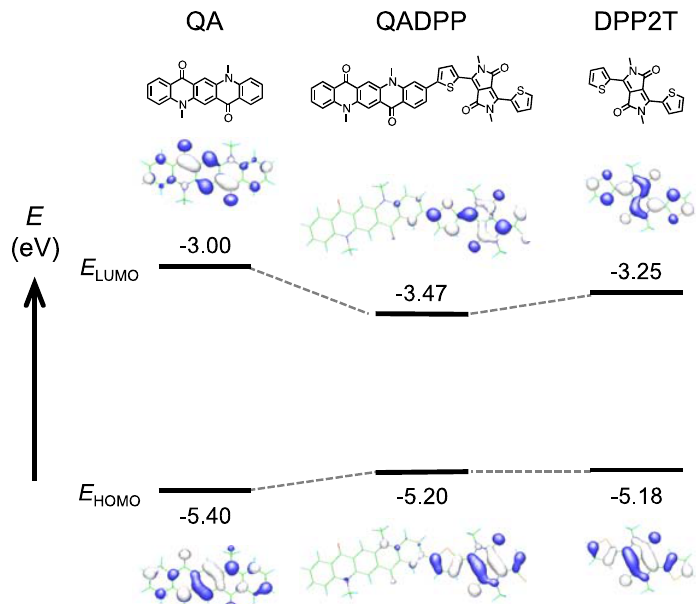
Figure 3. Computation (DFT at B3LYP/6-31(d) level) of the HOMO and LUMO geometry of quinacridone (QA, left), polymer repeat unit (QADPP, middle), and dithienyl diketopyrrolopyrrole (DPP2T), in which the methyl group is used as the